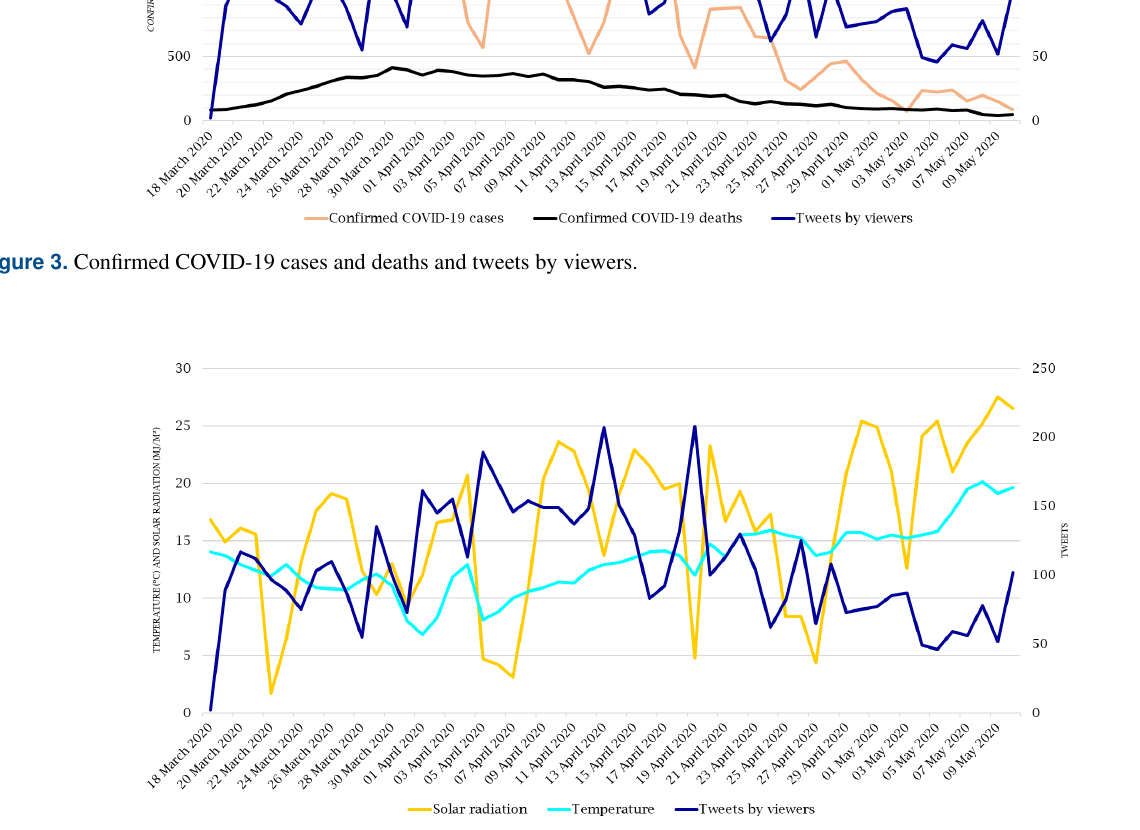
Figure 4. Solar radiation, temperature and tweets by viewers.